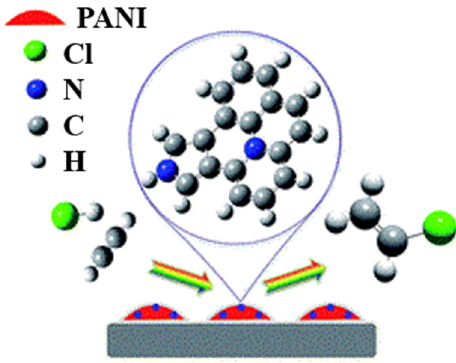
Figure 18. N-doped active carbon catalyst for acetylene hydrochlorination [128].